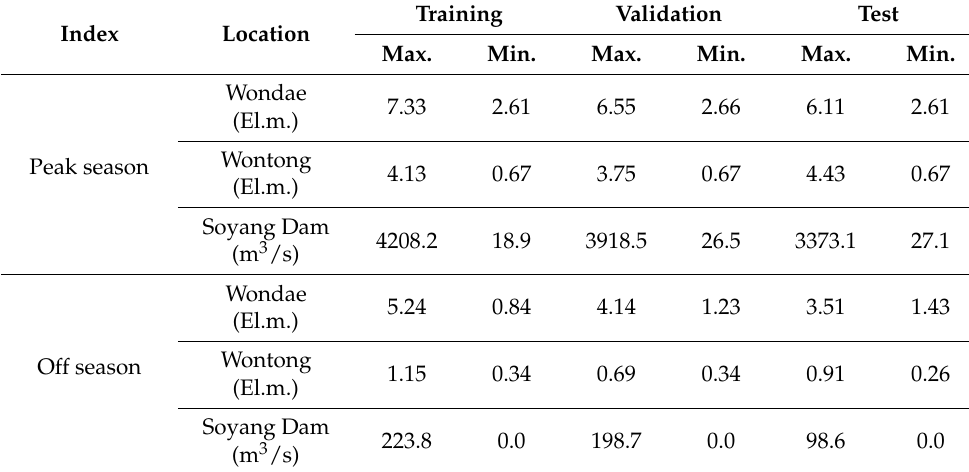
Table 2. Maximum and minimum values of each dataset.